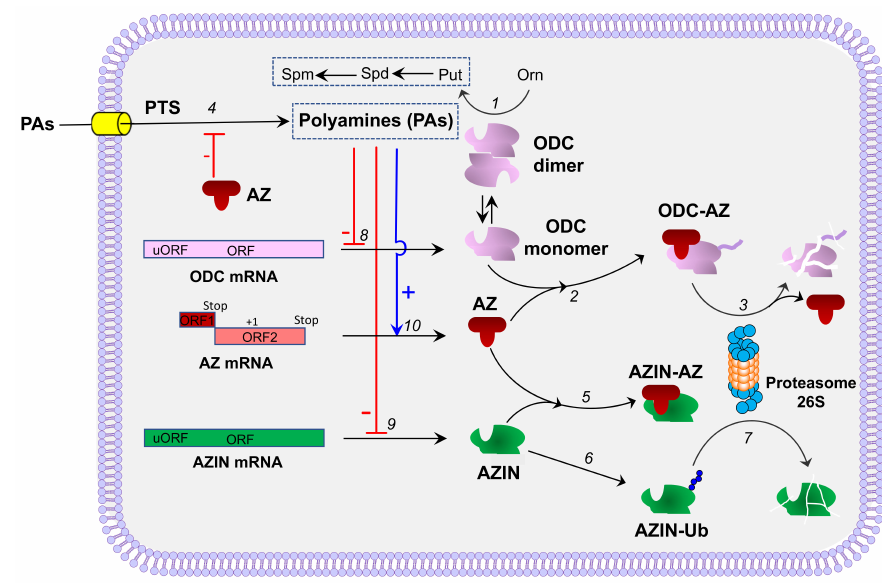
Figure 1. Antizymes and antizyme inhibitors in the control of polyamine homeostasis in mammalian cells. ( 1 ) The active ornithine decarboxylase (ODC) dimer catalyses the formation of putrescine